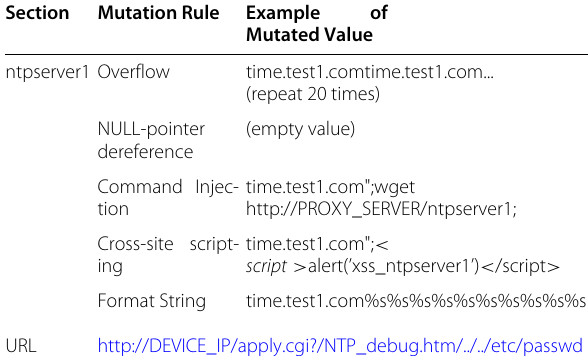
Table 1 Example of Mutation Rules for Variable